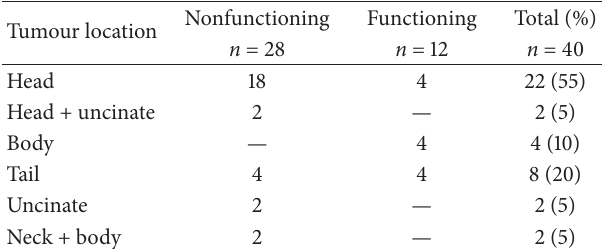
Table 2: Location of 40 pancreatic endocrine